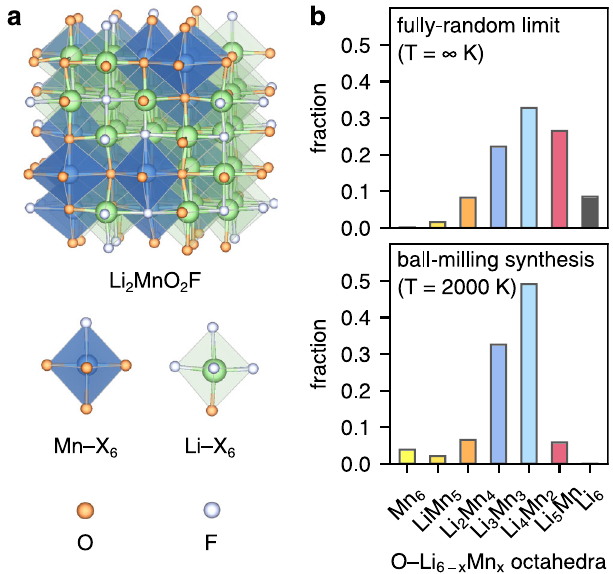
Fig. 1 | Structure and short-range order of Li 2 MnO 2 F. a Representative relaxed structure of disordered Li 2 MnO 2 F in a (2×2×2) expansion of the conventional rocksalt unit cell. b Frequency of O − Li x Mn 6 – x octahedra in Li 2 MnO 2 F at T = ∞ K (upper panel) derivedfrom abinomialdistributionwith n =6, p =2/3,representing the fully-random limit and at T =2000K (lower panel) obtained from cluster- expansion based Monte Carlo simulations, representing the pristine ‘ as-prepared ’